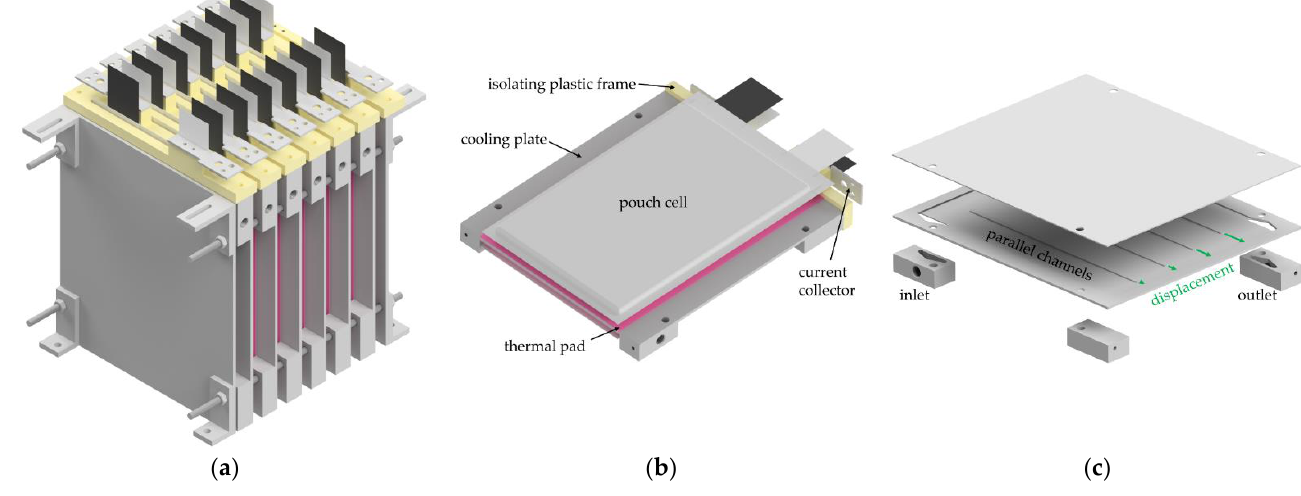
Figure 11. Setup of the battery block with cooling plates: ( a ) battery block with twelve pouch cells in between of six cooling plates. ( b ) Unit of a cooling plate with one pouch cell on both sides. ( c ) Exploded drawing of the cooling plate. Green arrows mark the different displacements of the internal walls.